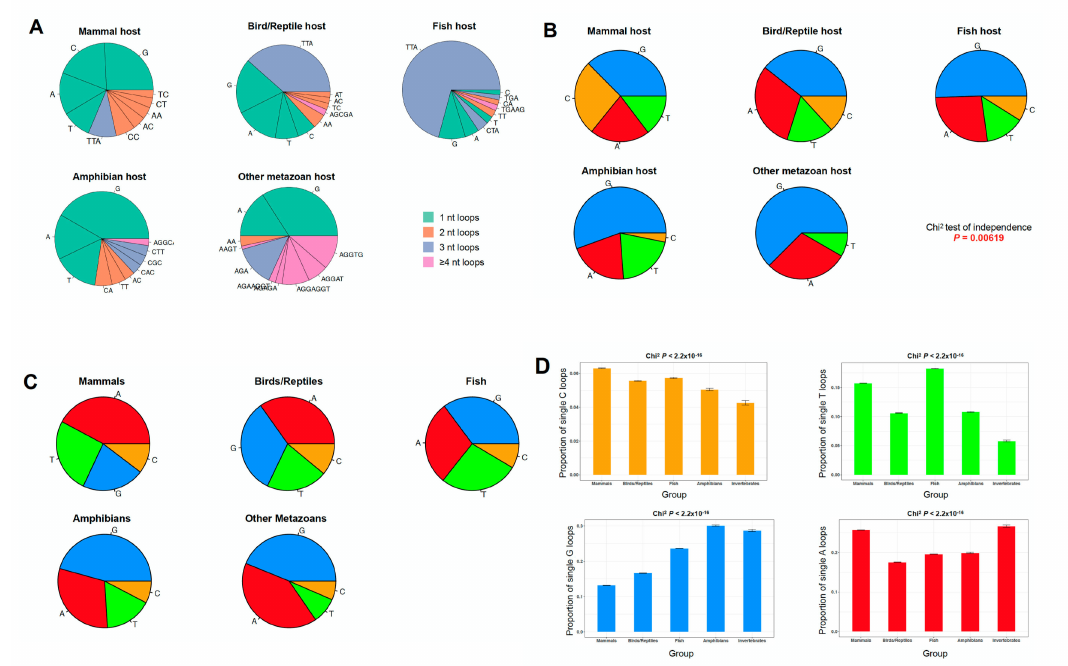
Figure 3. PQS loop content in Herpesviridae viruses and in various host animal genomes. ( A ) Most frequent N 1-7 loops by host group. Mammals, n = 65 viruses; Birds / Reptiles, n = 11 viruses; Fish, n = 6 viruses; Amphibians, n = 4 viruses; and Invertebrates, n = 7 viruses. ( B ) Single-nucleotide loop frequencies by host group. Blue, G loops; red, A loops; orange, C loops; and green, T loops, irrespective of their positions with the G4 sequence. Chi-square independence tests were used to evaluate the significance of the association between loop proportions and host group. ( C ) Single-nucleotide loop frequencies in 52 eukaryote genomes. Mammals, n = 18 genomes; Birds / Reptiles, n = 9 genomes; Fish, n = 8 genomes; Amphibians, n = 3 genomes; and Invertebrates, n = 9 genomes. ( D ) Proportion of single C (orange, top panel), T (green, top panel), G (blue, bottom panel), or A (red, bottom panel) loops by eukaryote groups. Bars indicate the upper and lower bounds of the 95% confidence intervals. Chi-square independence tests were used to evaluate the significance of the association between loop proportions and group. All pairwise nominal independence adjusted P -values <